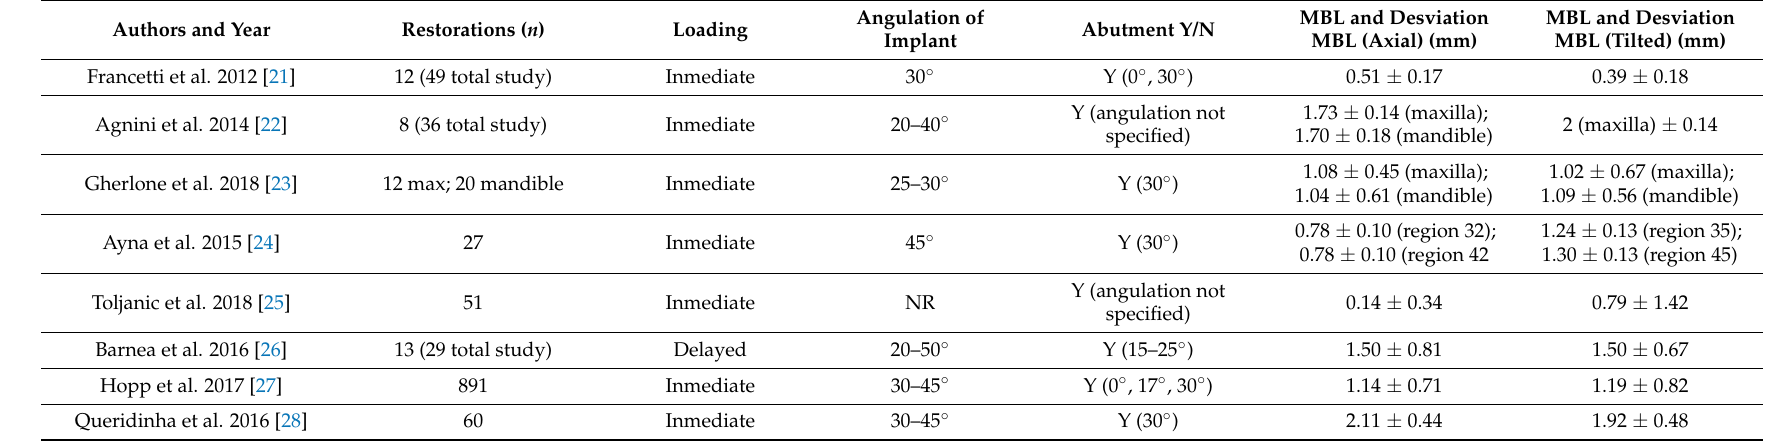
Table 2. Information about studies reviewed, evaluating straight implants compared with tilted implants supporting fixed restorations: study, number of restorations, loading, angulation of implants, abutment, marginal bone loss. (MBL: mean marginal bone loss; NR: Non